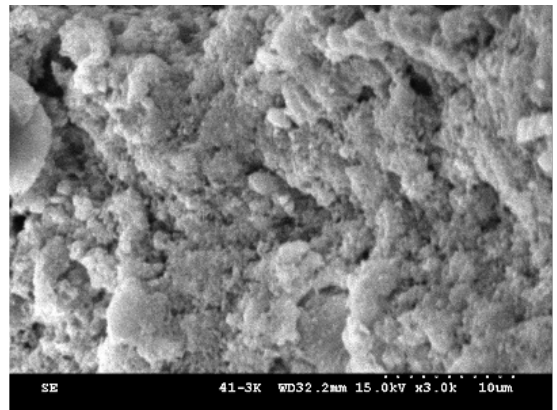
Figure 10. SEM photo of the polyolefin fiber.